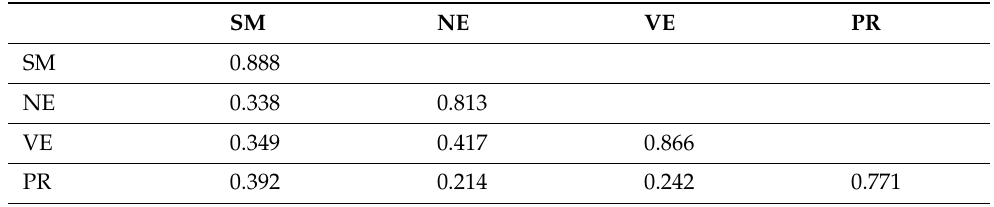
Table 4. Discriminant